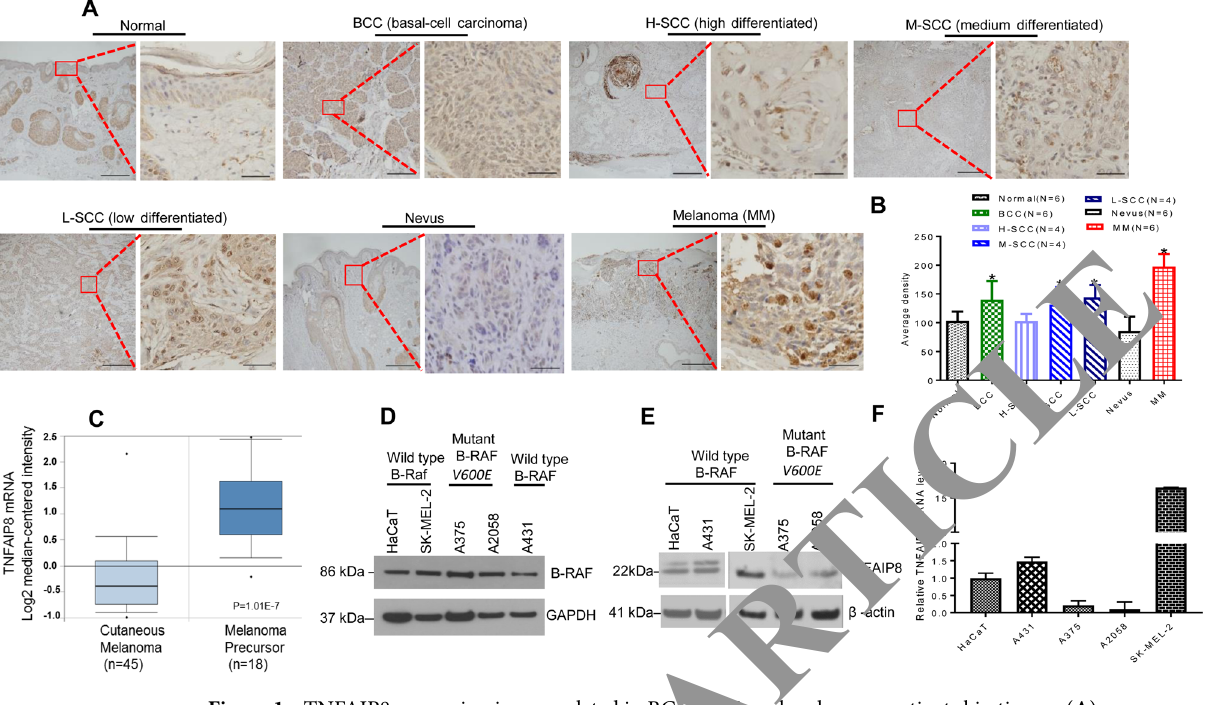
Figure 1. TNFAIP8 expression is upregulated in BCC, SCC, and melanoma patient skin tissues. ( A ) Relative immunohistochemical TNFAIP8 expression in indicated skin cancer tissues is presented. ( B ) Immunohistochemical expression levels of TNFAIP8 protein from normal skin (n = 6), BCC (n = 6), H-SCC (n = 4), M-SCC (n = 4), L-SCC (n = 4), nevus (n = 6), and melanoma (n = 6) tissues were quantified using ImageJ software (https:// imagej. nih. gov/ ij/) and plotted. The data represent mean ± SEM from 4 to 6 skin cancer tissues. * P < 0.05 relative to normal skin tissues. ( C ) Expression of TNFAIP8 transcripts between cutaneous melanoma (n = 45) and melanoma precursor (n = 18) samples were analyzed and presented from the Oncomine dataset (https:// www. oncom ine. org/ resou rce/ login. html accessed October 17, 2020). *** P < 0.001 relatives to cutaneous melanoma tissues. ( D , E ) Expression of wild-type B-RAF, mutant B-RAF V600E , and TNFAIP8 in HaCaT, SK-MEL-2, A431, A375, and A2058 cells were analyzed by western blotting. Fifty micrograms of lysates from normal and skin cancer cells were immunoblotted with B-RAF, TNFAIP8, GAPDH, and β-actin antibodies. Immunoreactive bands were visualized using ECL chemiluminescence detection reagents after exposing the blots on X-ray films ( D ) or by scanning the blots with an Odyssey CLx Imager ( E ). The immunoblot scans were converted into grayscale and presented. ( F ) Expression of TNFAIP8 mRNA from indicated normal skin cells and skin cancer cells were analyzed by RT/qPCR as described in the “Materials and methods” melanoma cells expressed isoform two predominantly but not in normal HaCaT cells. Normal HaCaT cells, A431, A375, A2058 cells expressed isoform one, whereas expression of isoform one is not observed in SK-MEL-2 cells suggesting that, skin cancer cells expressed isoform two predominantly (Fig. 2B) and the involvement of TNFAIP8 variant/isoform 2 in lung cancer and liver cancer development and progression has been reported earlier 37,43 . (Fig. 2C,D). Treatment of TNFα (10–20 ng/ml) induced the expression of TNFAIP8 protein in normal HACaT skin cells as well as in skin cancer cell lines (Fig. 2C). Consistent with immunoblotting data, the relative mRNA TNFα (50 ng/ml) (Fig. 2D). Interestingly, B-RAF mutant A375 and A2058 melanoma cell lines which expressed lower levels of TNFAIP8, upon a dose-dependent treatment with TNFα (10–50 ng/ml) induced TNFAIP8 pro- tein expression (Fig. 2C) suggesting that TNFα induced TNFAIP8 expression in normal and skin cancer cell lines irrespective B-RAF background. Since TNFAIP8 modulates cell survival/proliferation in several cancer cell lines, the role of TNFα mediated induction of TNFAIP8 in skin cancer cell survival was analyzed by MTT assay (Fig. 2E). The data suggest that induction of TNFAIP8 by TNFα (10–20 ng/ml) increased cell survival in normal HaCaT cells as well as in A431 cells and A375, A2058 melanoma cell lines significantly, whereas, a higher concentration of TNFα (50 ng/ml) treatment decreased cell survival in A431, A375 and A2058 skin cancer cell lines (Fig. 2E). We also analyzed the time-dependent effect of TNFα (20 ng/ml) on the expression of TNFAIP8 and cell survival (Supplementary Fig. S1A,B). Our data suggest that treatment of TNFα (20 ng/ml) increased TNFAIP8 expression and cell survival after 12–24 h and significantly decreased the TNFAIP8 expression and cell survival after 48 h treatment (Supplementary Fig. S1A,B) suggesting that, TNFα regulates the expression of TNFAIP8 and cell survival in skin cancer cells with a time-dependent manner.